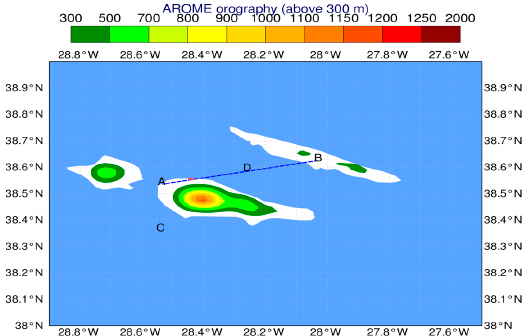
Figure 2. Approximate flight path (blue dashed line) and AROME orography. Shading shows elevation in meters. Pink marker shows the aerodrome location. “AB” and “CD” are endpoints of cross-sections analyzed in subsequent sections.